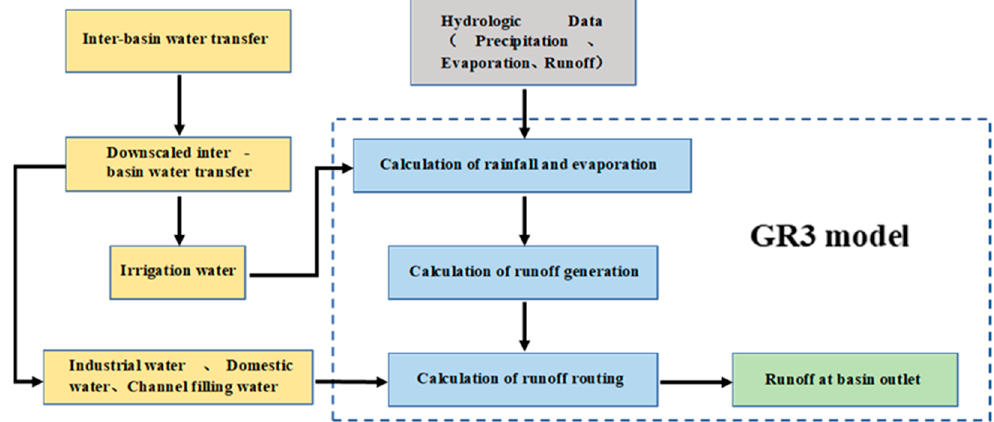
Figure 4. Flow chart of inter-basin water transfer processing and integration into GR3 .